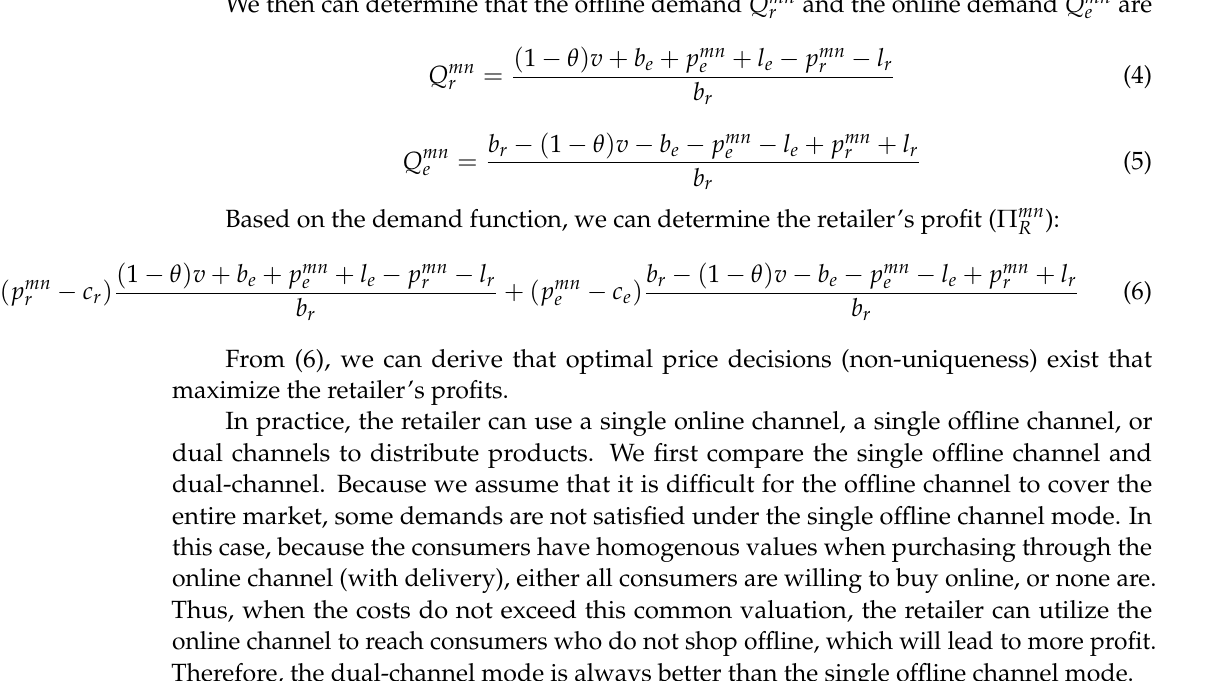
Figure 1. Retailer’s demand under non-BOPS and monopoly case.